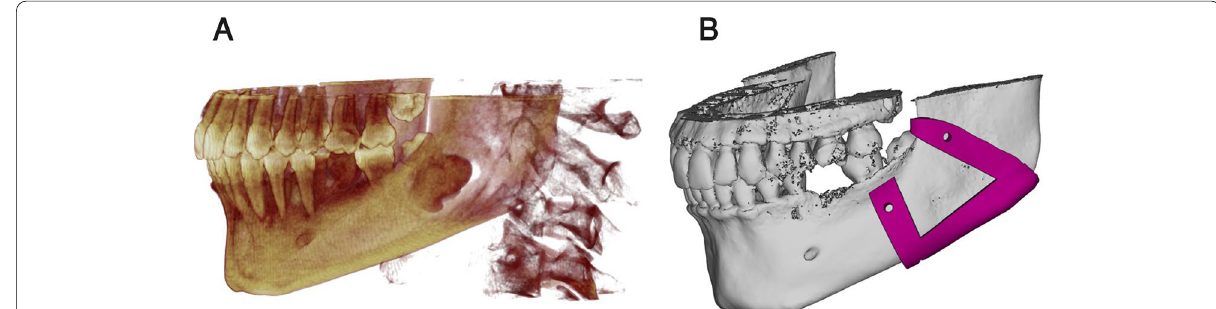
Fig. 2 Preoperative virtual planning. A 3D image showing the extension of the lesion in the bone. B Patient-specific osteotomy locating guide constructed on the bone surface